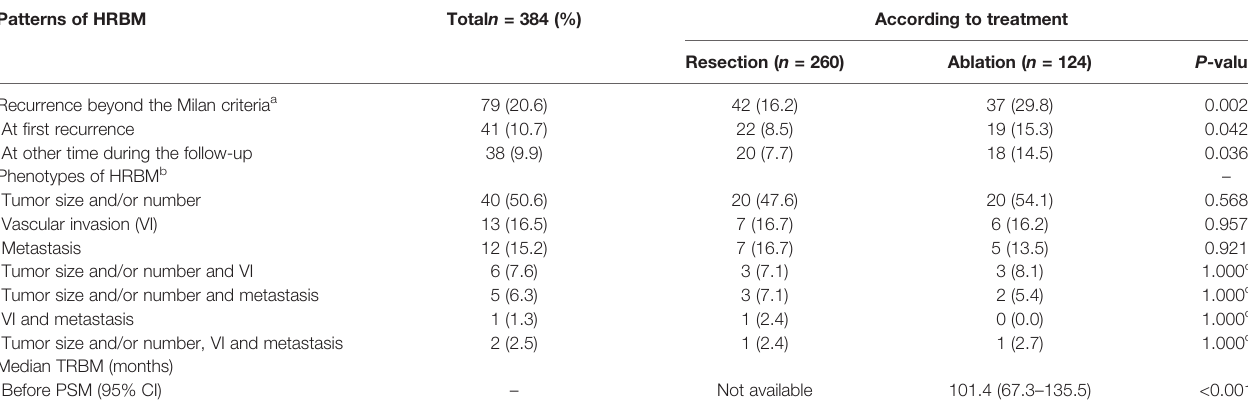
TABLE 3 | Patterns of HRBM after resection or ablation as fi rst-line therapy for patients with single-nodule HBV-associated HCC of 2 – 3 cm before PSM. Patterns of HRBM Total n = 384 (%)